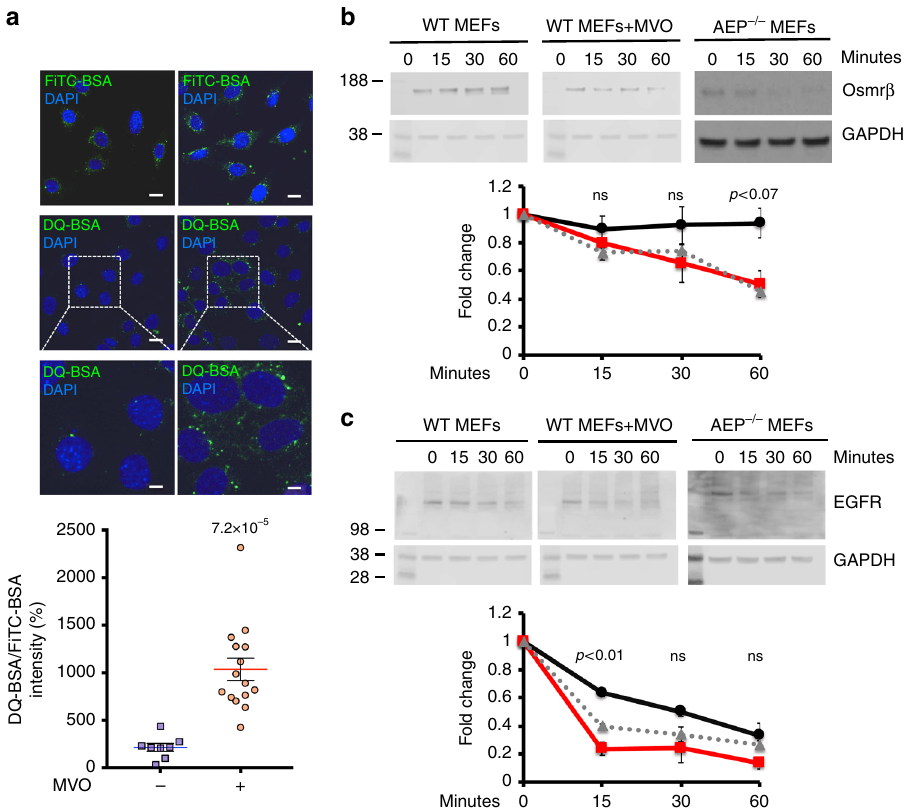
Fig. 3 Increased lysosomal proteolytic capacity induced by suppression of AEP activity. a FiTC-BSA uptake and DQ-BSA degradation rates in WT 3T3s treated (red circles) or untreated (blue squares) with 50 μ M MVO26630 for 16 h. Data are means ± SEM of n = 8 microscopic fi elds for untreated and n = 15 microscopic fi elds for MVO-treated. (Scale bar = 20 μ m). b Time course of degradation of oncostatin M receptor beta (Osmr β ) in WT MEFs treated (dashed grey line) or untreated (black solid line) with 50 μ M MVO26630 for 16 h and AEP − / − MEFs (red solid line) following receptor downregulation by oncostatin M. Relative intensity of each Osmr β band was calculated for three independent experiments. c Time course of degradation of epithelial growth factor receptor (EGFR) in WT MEFs treated (dashed grey line) or untreated (black solid line) with 50 μ M MVO26630 for 16 h and AEP − / − MEFs (red solid line) following receptor downregulation by epithelial growth factor. Relative intensity of each EGFR band was calculated for three independent experiments. Statistical signi fi cance was calculated using a two-sided unpaired t- test. ns = not signi fi